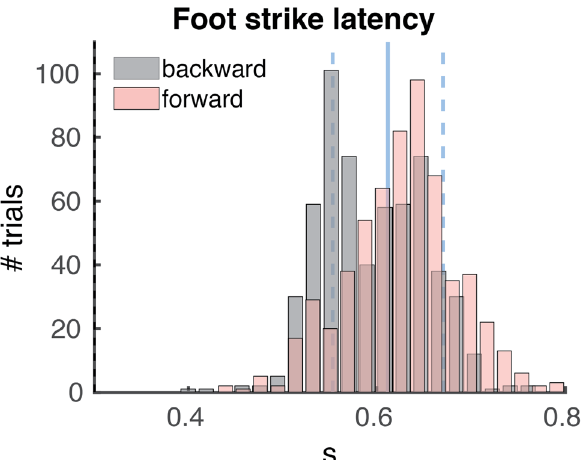
Figure 2. Foot strike latencies. Single trial foot strike latencies in the forward (red) and backward (grey) direction. The solid vertical blue line represents the overall mean foot strike latency (611 ms) and the dashed blue lines represent the standard deviation (58 ms). Presented foot strikes all occurred during the constant velocity phase of the platform perturbation (0.3–0.8